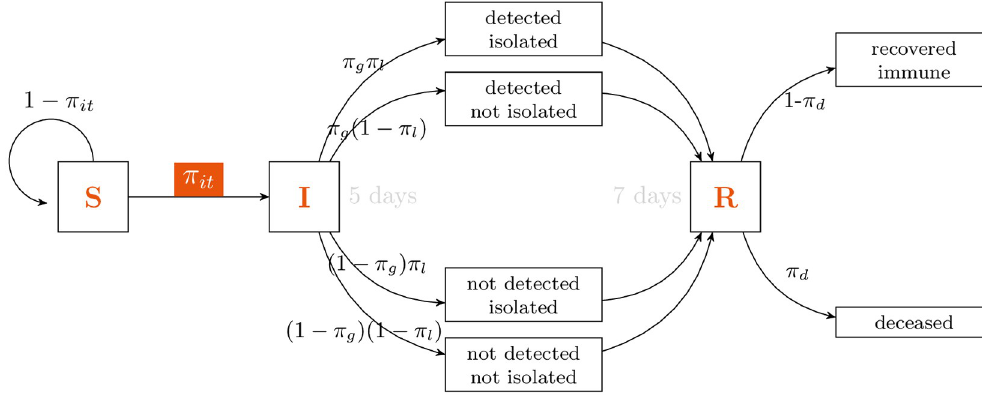
: infected individuals may be detected it